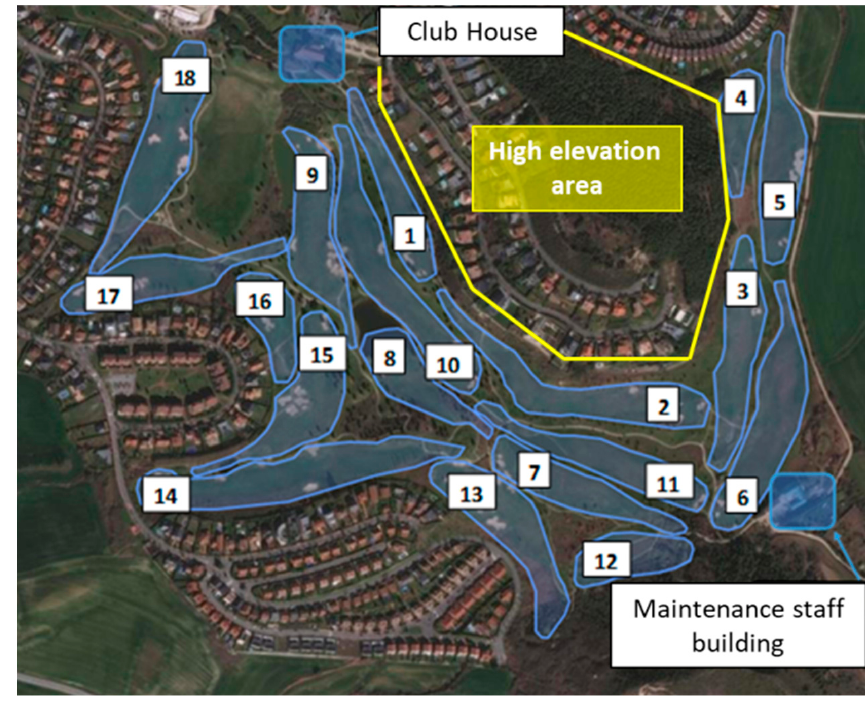
Figure 1. The golf course with 18 holes under analysis.